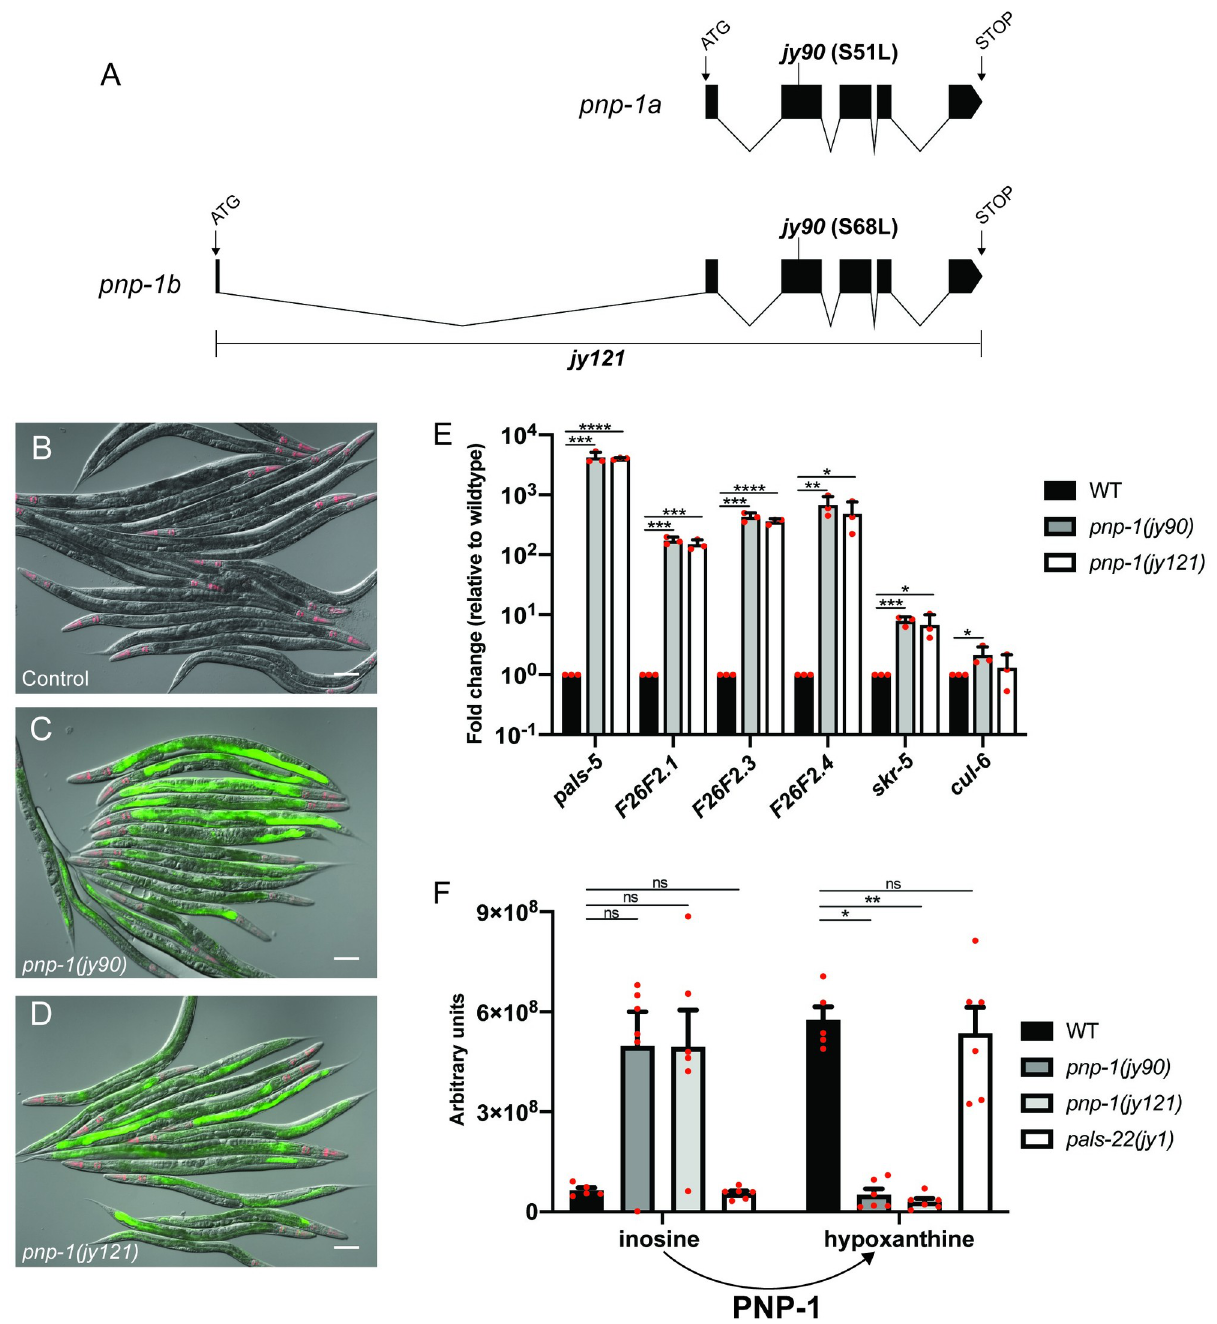
Fig 1. pnp-1 mutants have increased expression of IPR genes. A) Gene structure of the two isoforms of pnp-1 with exons indicated as black boxes. 5’ and 3’ untranslated regions are not shown. B-D) pals-5p :: gfp IPR reporter expression in wild-type animals, pnp-1(jy90) and pnp-1(jy121) mutants. myo- 2p :: mCherry is a pharyngeal marker for the presence of the IPR reporter transgene. Scale bar is 100 μ m. E) qRT-PCR of a subset of IPR genes in pnp-1 (jy90) and pnp-1(jy121) mutants. Fold change in gene expression is shown relative to wild-type animals. Graph shows the mean fold change of three independent experiments. Error bars are standard deviation (SD). Mixed stage populations of animals were used. ���� indicates p < 0.0001 by one-tailed t-test. F) Quantification of inosine and hypoxanthine levels in pnp-1 and pals-22 mutants from metabolomics analysis. Graph shows the mean levels of metabolites from six independent experiments for pnp-1(jy121) , pnp-1(jy90) and pals-22(jy1) mutants, and five independent experiments for wild-type animals. Error bars are standard error of the mean (SEM). �� indicates p < 0.01 by the Kruskal-Wallis test. E, F) Red dots indicate values from individual experiments. See materials and methods for more information.